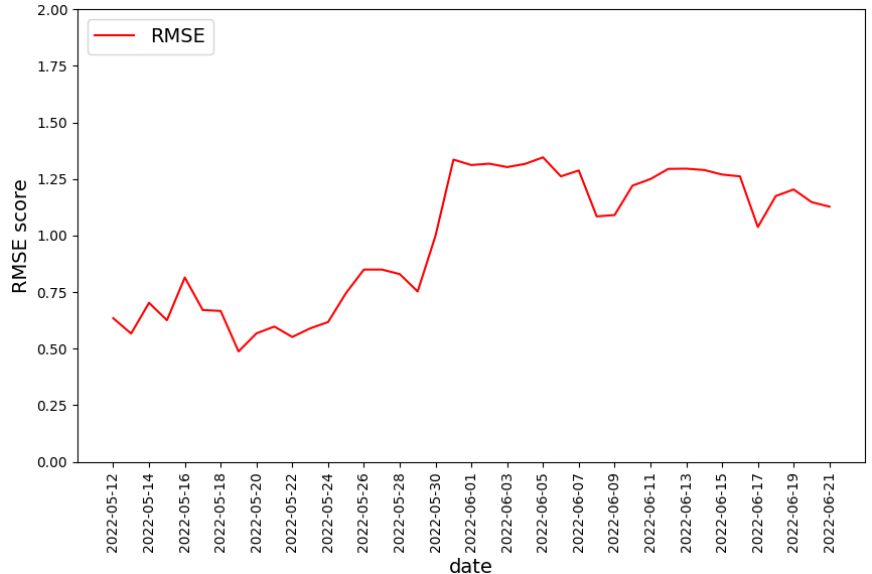
Figure 12. RMSE score for the predictor output predicting the degree of maliciousness of the